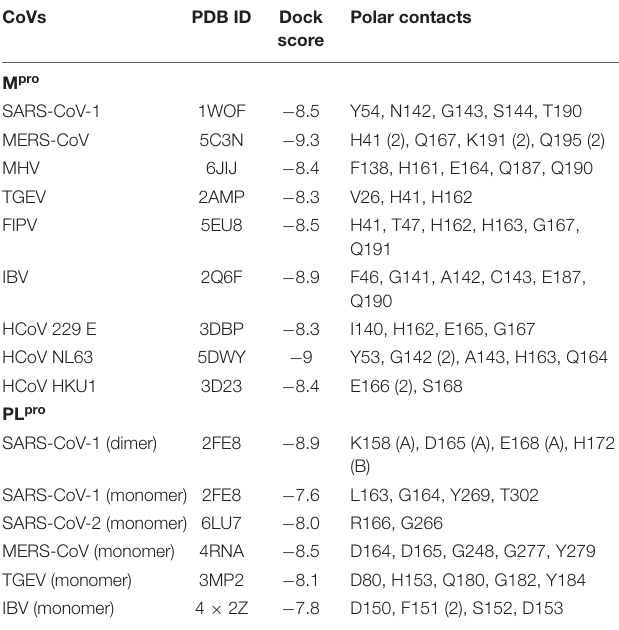
TABLE 5 | Molecular docking results of other phycobilins with proteases of SARS-CoV-2. Other phycobilins